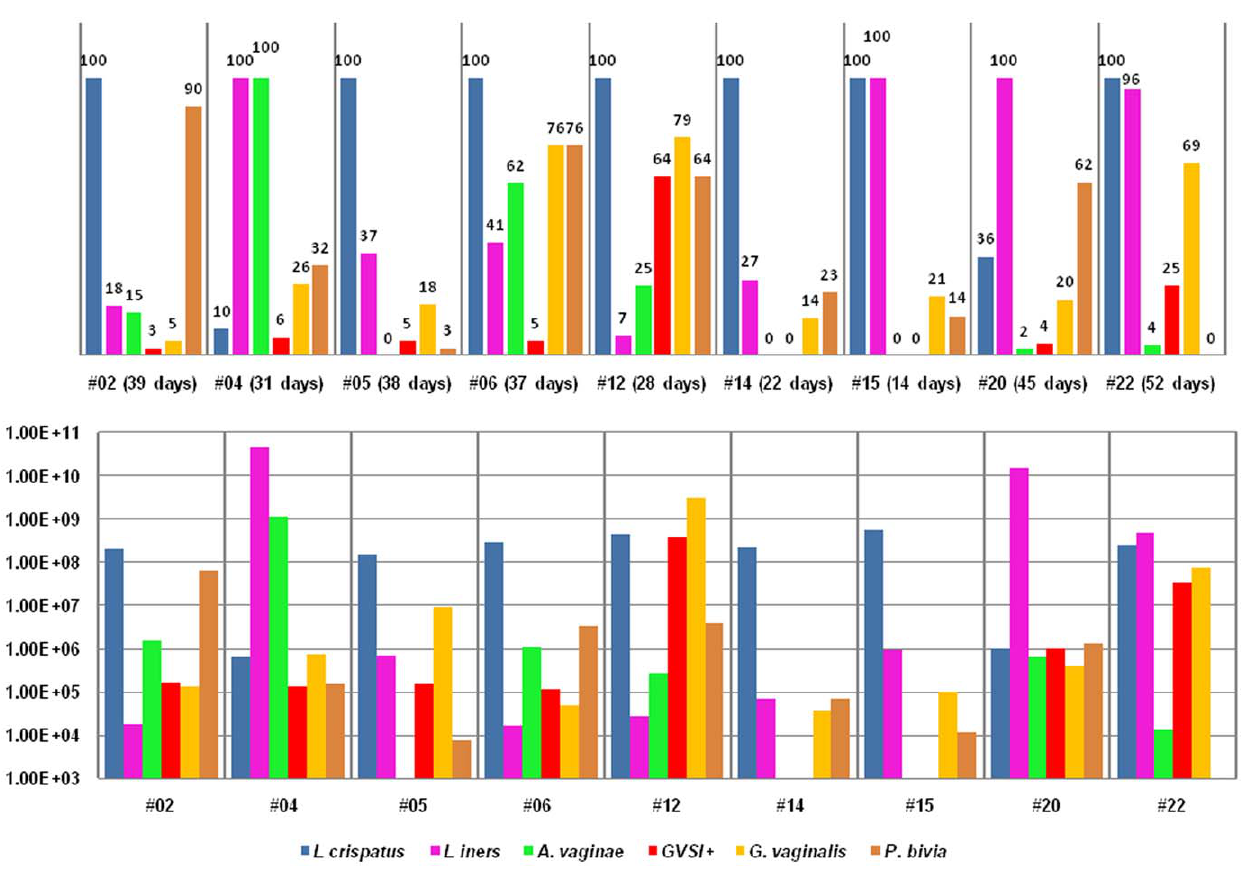
Figure 1. The presence and average concentrations of the 5 species during the study in group N. Legend: The chart above represents the total presence (%) of the 5 species during the days that were analysed. In addition, the actual days present versus the total days analysed are also given. The chart below represents the average concentrations (cells/ml) of the 5 species during the days that were analysed.